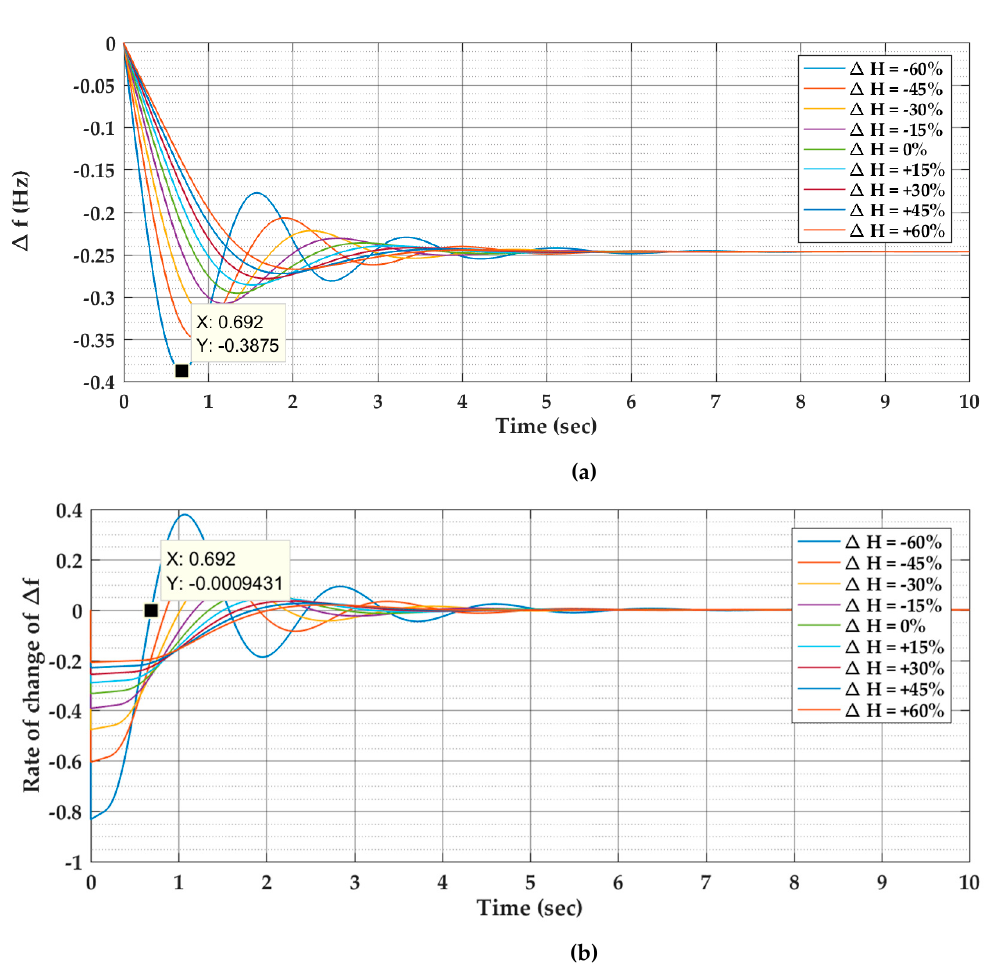
Figure 4. Effects of varying H on the power system frequency response (PSFR) for a stable power system with primary control. ( a ) Frequency deviation due to step load disturbance. ( b ) Rate of change of the frequency deviation.